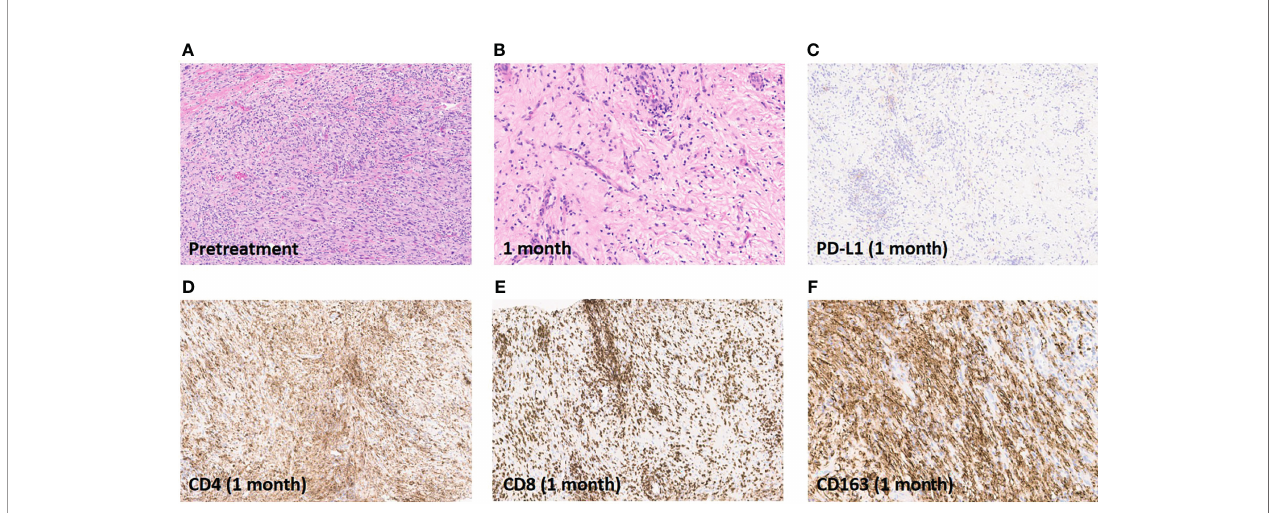
FIGURE 3 | Pathologic and immunohistochemical assessment of response. (A) , Excision specimen of recurrent tumor one year prior to ILI. (B) , Tibial biopsy one month after ILI showing no viable tumor. (C) , Absence of PD-L1 expression post-ILI and PD-1 inhibition. (D) , Brisk CD4+ T cell in fi ltration in tibial biopsy one month after ILI. (E) , Brisk CD8+ T cell in fi ltration in tibial biopsy one month after ILI. (F) , Brisk CD163+ macrophage in fi ltration in tibial biopsy one month after ILI. Images are presented at 20x magni fi